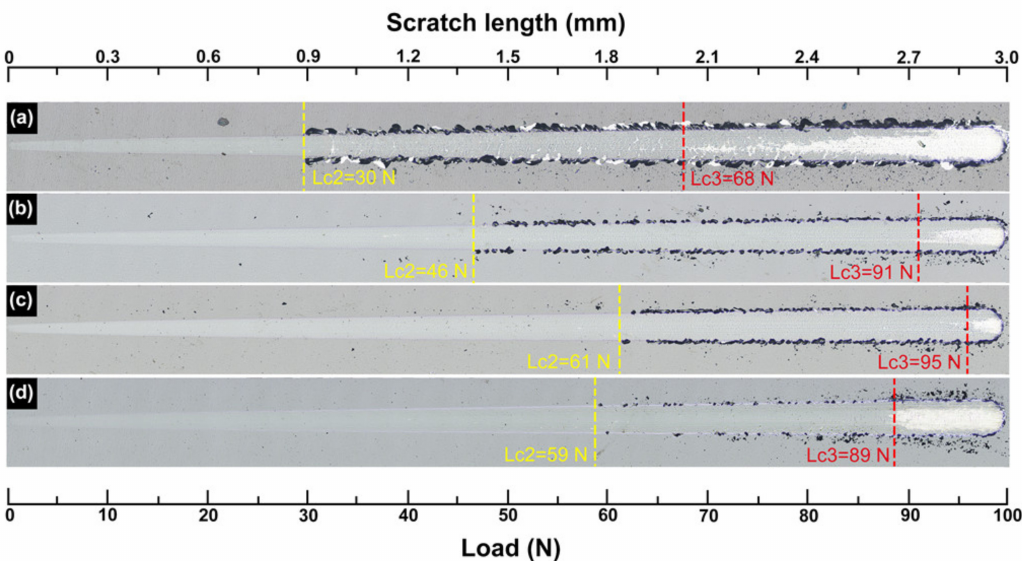
Figure 6. Typical scratch morphologies of the TaN x coatings deposited with ( a ) 0 V, ( b ) − 100 V, ( c ) − 200 V and ( d ) − 300 V. The corresponding critical loads of the coatings are also presented in the images.